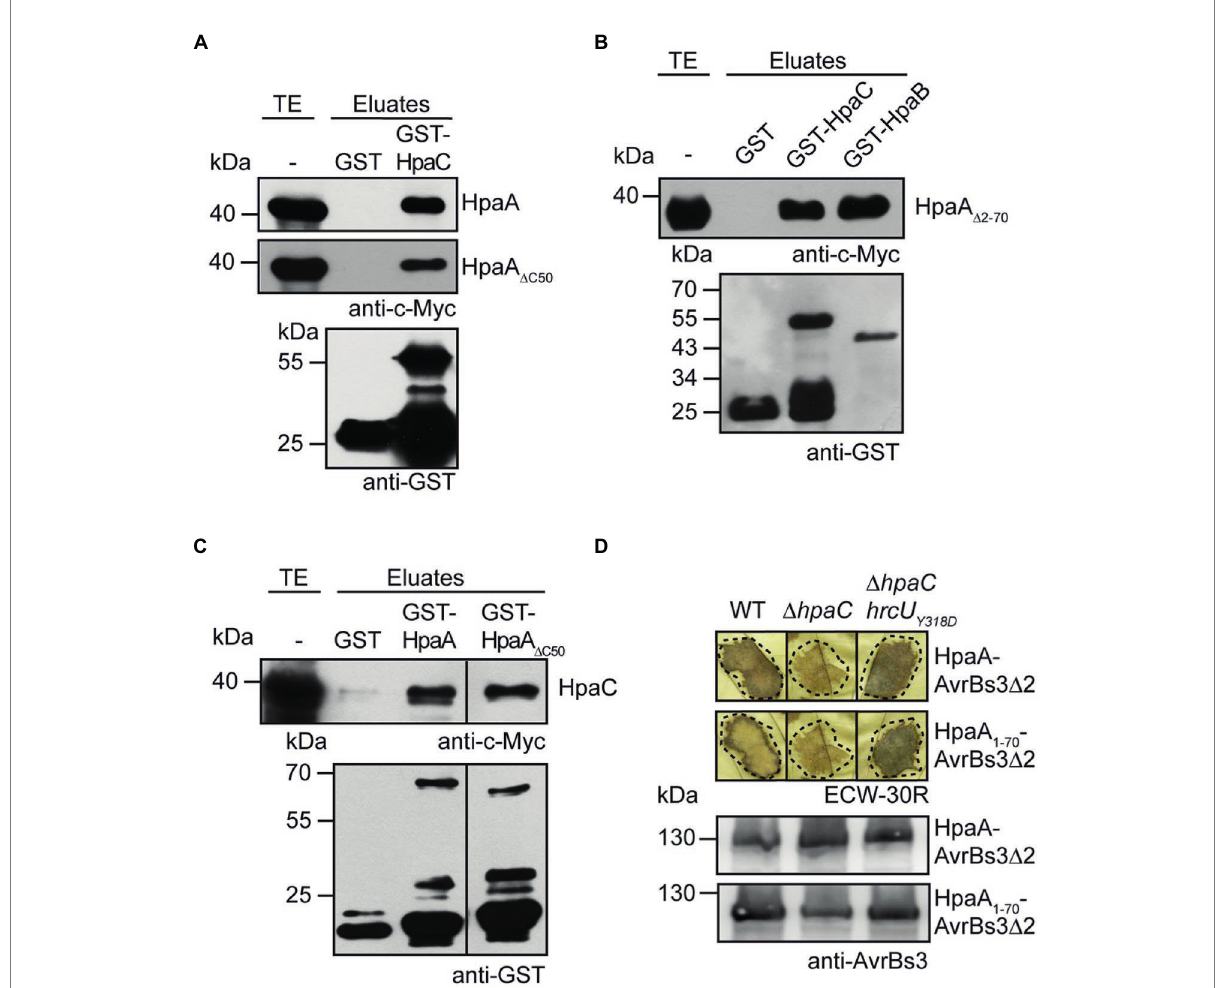
FIGURE 5 HpaA interacts with the T3S4 protein HpaC and depends on the predicted HpaC-mediated conformational change in HrcU C for efficient translocation. (A) HpaA interacts with HpaC independently of the C-terminal HpaB-binding site. GST and GST-HpaC were immobilized on glutathione sepharose and incubated with bacterial lysates containing HpaA-c-Myc or HpaA -c-Myc as indicated. Total cell extracts (TE) and ∆ C50 eluted proteins (eluates) were analysed by immunoblotting using c-Myc epitope- or GST-specific antibodies. (B) The N-terminal 70 amino acids of HpaA are dispensable for the interaction with HpaC. GST, GST-HpaC and GST-HpaB were immobilized on glutathione sepharose and incubated with a bacterial lysate containing HpaA -c-Myc. TE and eluates were analysed as described in (A) . (C) The C-terminal HpaB- ∆ 2-70 binding site in HpaA is dispensable for the interaction with HpaC. GST, GST-HpaA and GST-HpaA were immobilized on glutathione ∆ C50 sepharose and incubated with a bacterial lysate containing HpaC-c-Myc. TE and eluates were analysed as described in (A) . (D) Efficient translocation of HpaA depends on HpaC. X. euvesicatoria strains 85* (WT), 85* ∆ hpaC ( ∆ hpaC ) and 85* ∆ hpaChrcU Y318D ( ∆ hpaChrcU Y318D ) containing HpaA-AvrBs3 ∆ 2 or HpaA 1-70 -AvrBs3 ∆ 2 as indicated were infiltrated into leaves of AvrBs3-responsive ECW-30R pepper plants. For the better visualization of the HR, leaves were bleached in ethanol 2 dpi. Dashed lines indicate the infiltrated areas. For protein analysis, bacterial cell extracts were analysed by immunoblotting, using an AvrBs3-specific